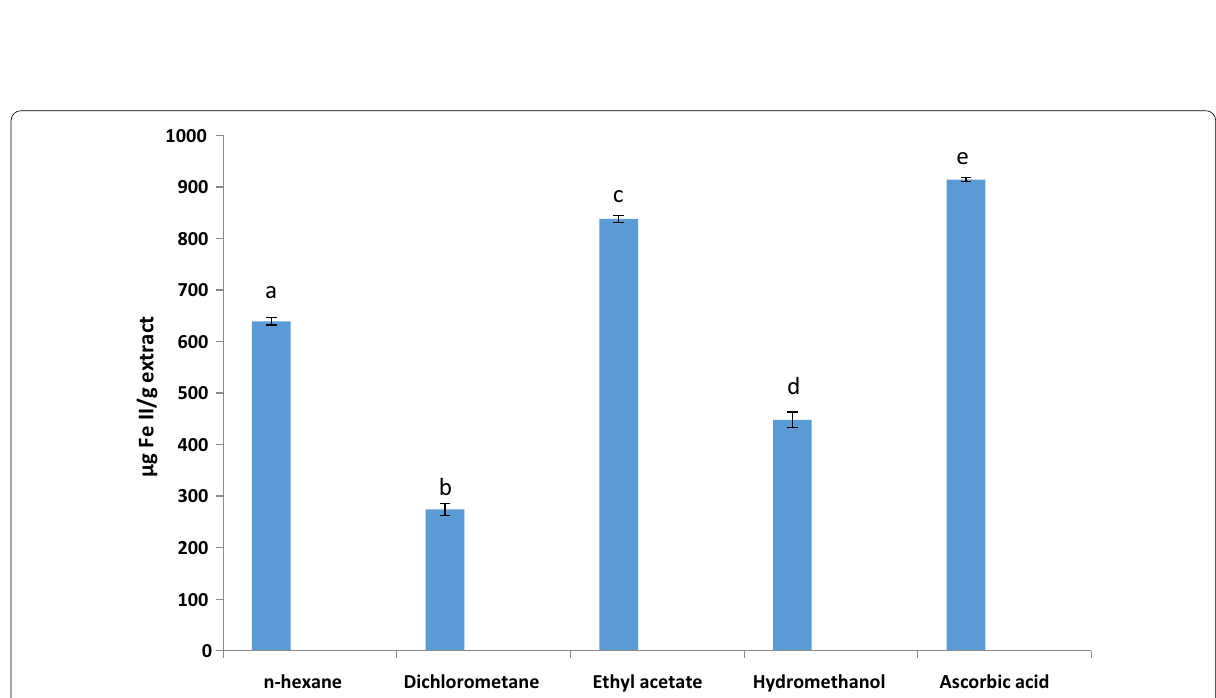
Fig. 6 Ferric reducing antioxidant potential (FRAP) of fractions from leaf extract of I. gabonensis . Values are expressed as mean Different alphabets on bars show that values for the fractions are significantly different ( p < 0.05) from each other. The ethyl acetate fraction from leaf extract of I. gabonensis had significantly higher ( p < 0.05) FRAP value in comparison with the other fractions. However, ascorbic acid standard had significantly higher ( p < 0.05) FRAP value than ethyl acetate